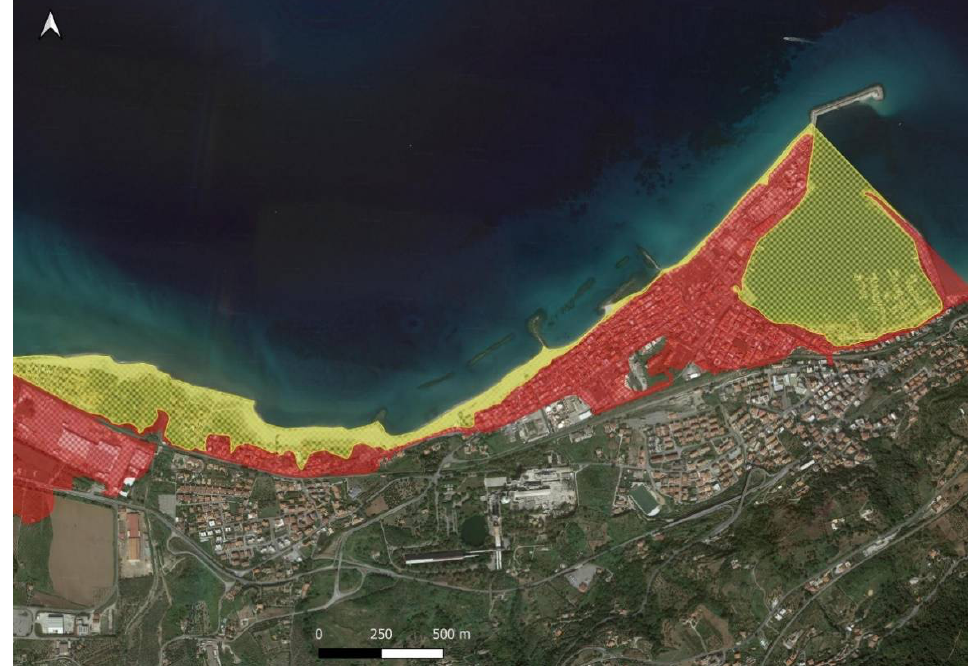
Figure 7. Vibo Marina. Legend: Yellow, the floodable area in the current scenario; red, the floodable area in the future scenario.